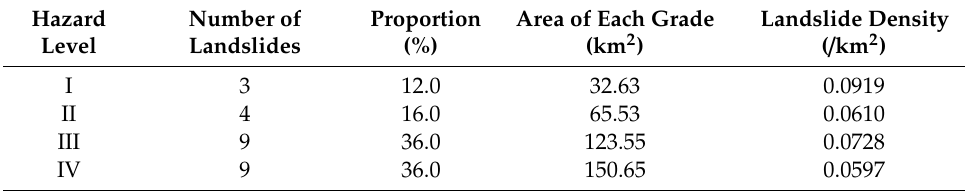
Table 8. The prediction ability analysis of the model.